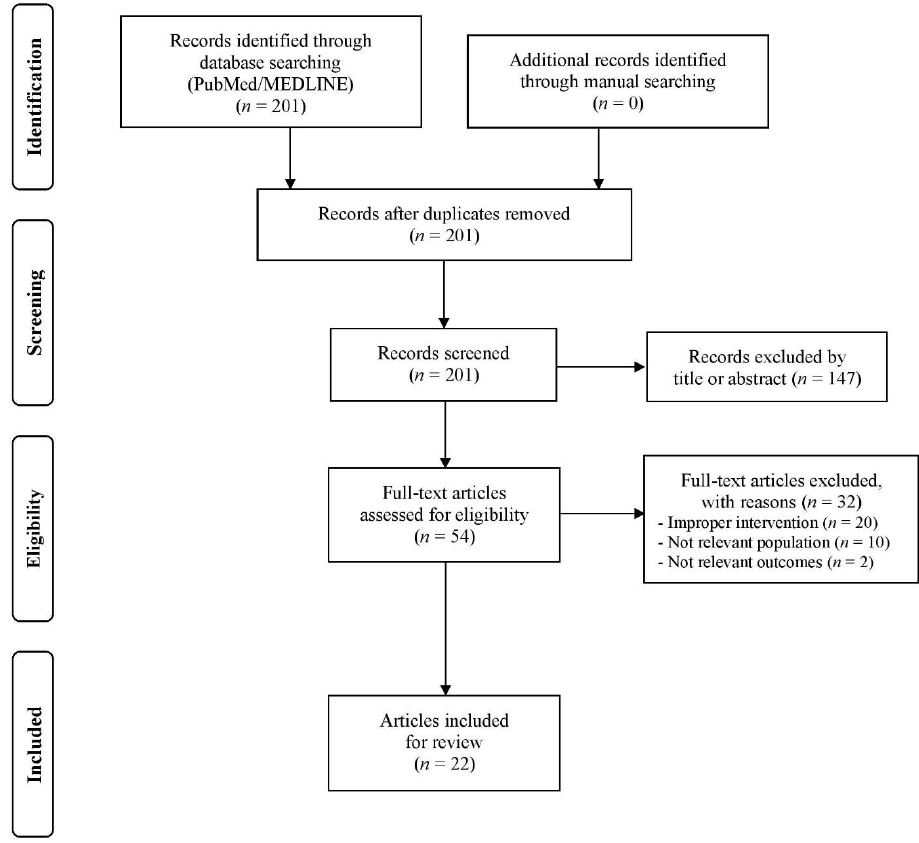
Figure 2. Flowchart of the systematic literature search.